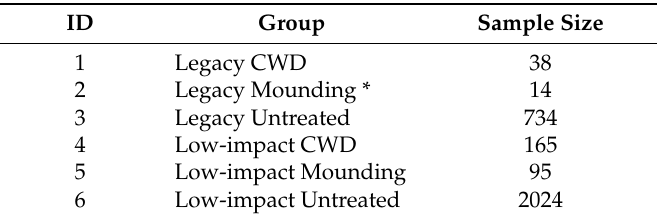
Table 3. Seismic lines were grouped based on size and treatment classes. Size classes include legacy and low-impact lines. Treatment classes include untreated, CWD, and mounding. * Legacy Mounding lines were discarded due to their small sample